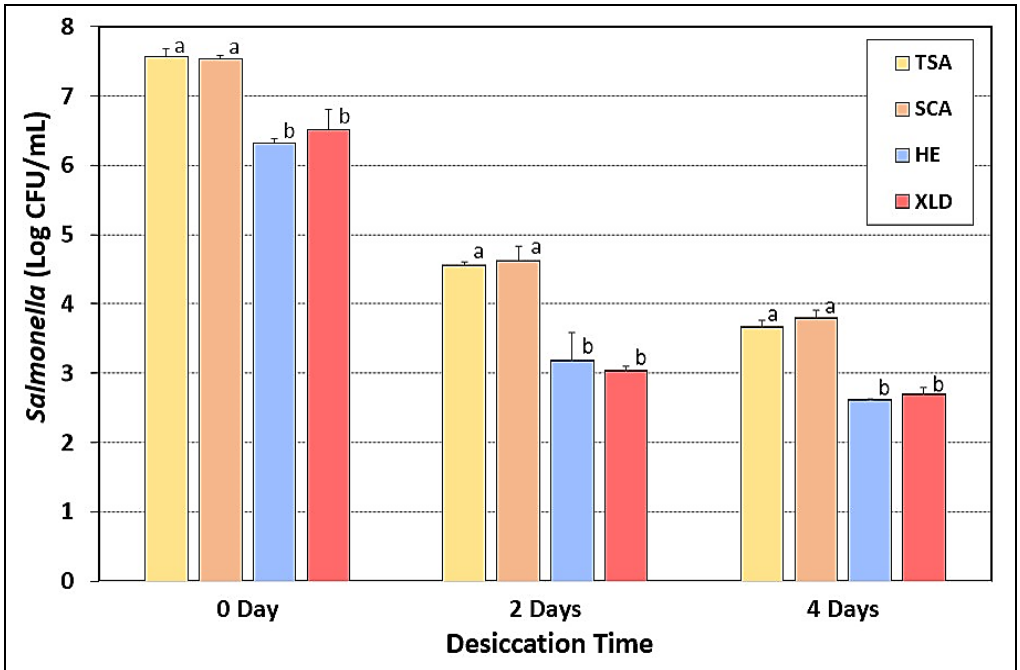
Figure 8. Desiccation-stress response of five-serovar mixtures of Salmonella inoculated on the surface of raw beef pieces and subjected up to 4-days drying in a humidity chamber at 23.9 ◦ C (75 ◦ F) and 55% RH. Treated samples were then plated on TSA, SCA, HE, and XLD containing spectinomycin (5 ug / mL), novobiocin (50 ug / mL), and clindamycin (5 ug / mL). Cultures in the mixture included S . Thompson 120, S . Heidelberg F5038BG1, S . Hadar MF60404, S . Enteritidis H3527, and S . Typhimurium H3380.